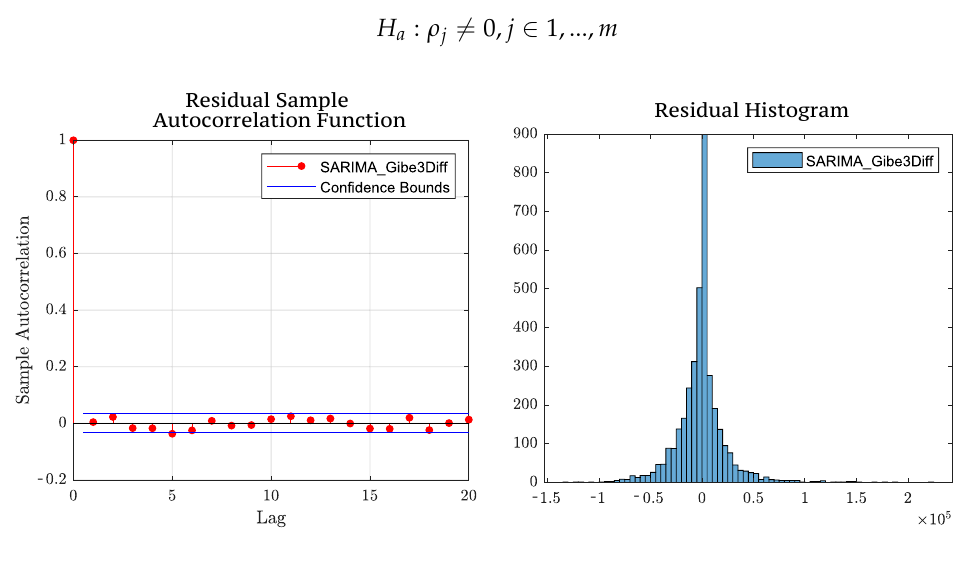
Figure 5. Residual diagnosis of the differenced Gibe 3 time series.